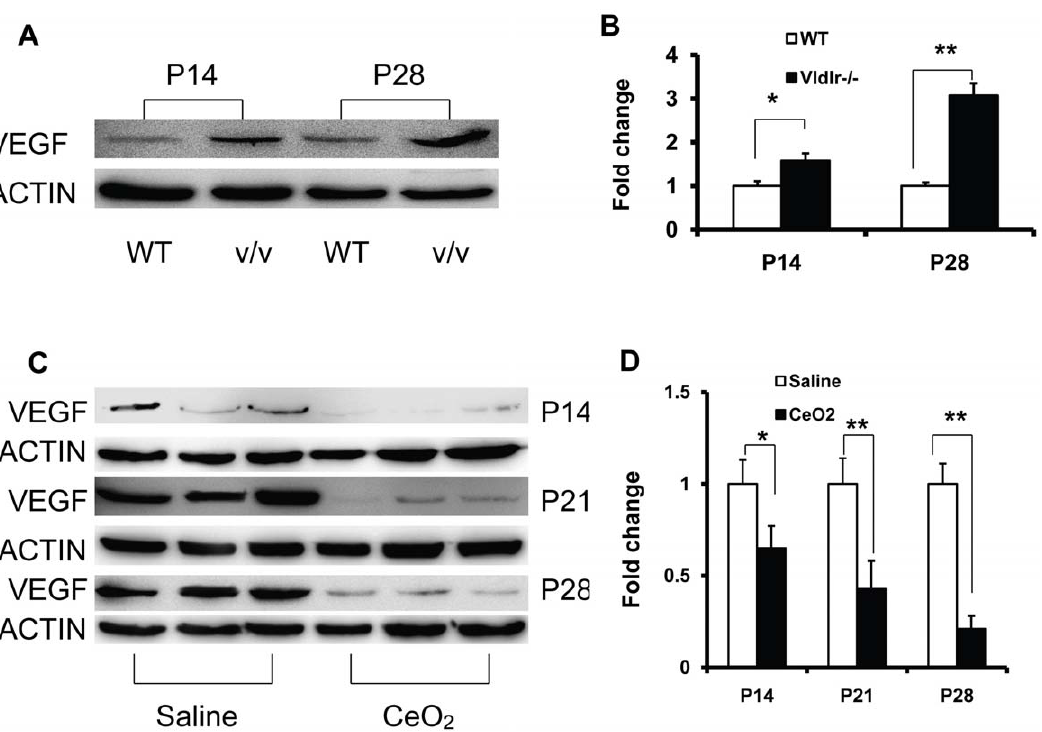
Figure 3. Nanoceria prevent the ectopic increase of VEGF during postnatal development of the Vldlr-/- retina. ( A ) Western immunoblots show that VEGF levels were higher in the Vldlr-/- retinas than in the WT at P14 and P28. Densitometry of these bands ( B ) indicated that by P28 the Vldlr-/- retina had about 3 fold more VEGF than the WT retina. Ectopic developmental increases (P14, P21, P28) of VEGF in the Vldlr-/- retina were seen in the immunoblots ( C ) of the retinas of saline injected Vldlr-/- mice, and significant reduction of VEGF was observed in retinas of mice injected with nanoceria at P7. Densitometric analysis ( D ) of the bands showed about a five-fold decrease in VEGF level by P28 following injection of nanoceria at P7.